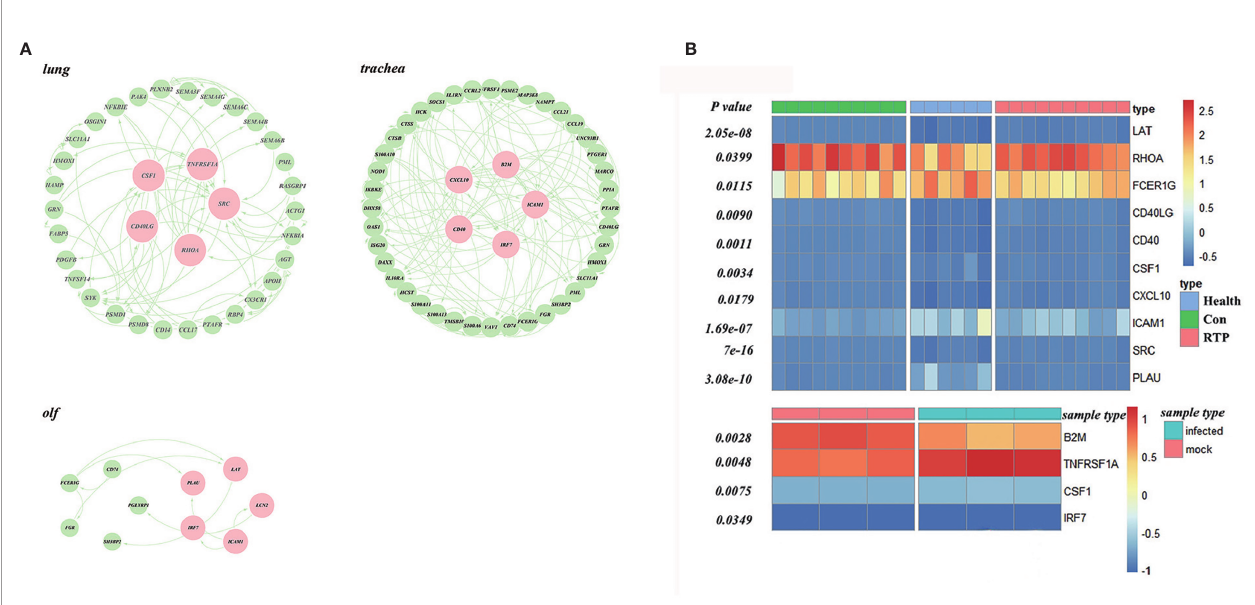
FIGURE 6 | Screening and validation of hub genes in multiple organs after SARS-CoV-2 infection. (A) Hub genes in the protein – protein interaction (PPI) network screened using the PageRank algorithm (Red ones indicate the hub genes). (B) Validation of hub genes based on datasets GSE166253 and GSE162615, GSE166253 and